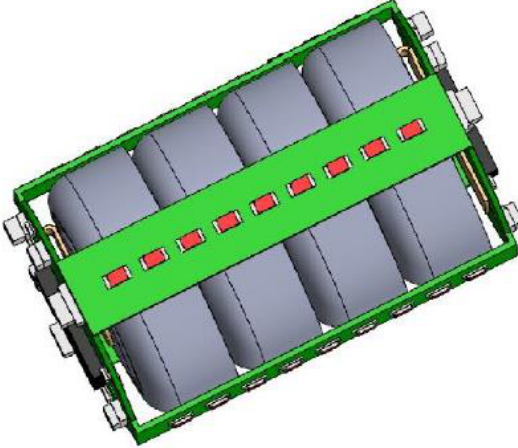
Figure 7. Capsule electronics with embedded batteries.